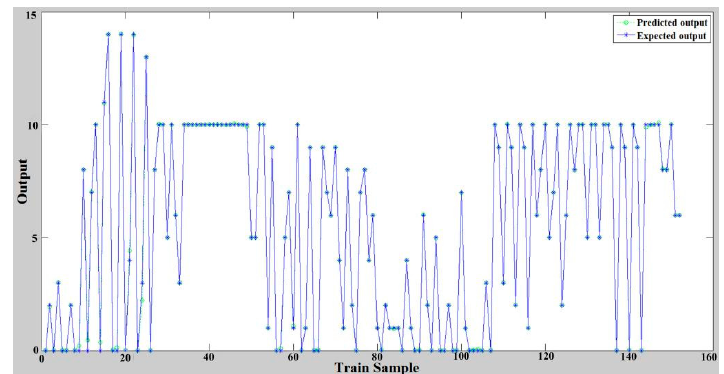
Figure 8. The fitting result diagram of training samples.